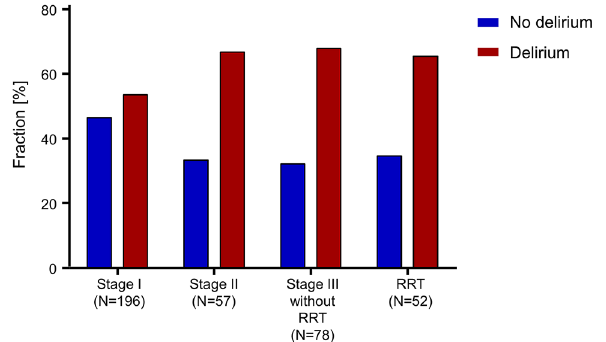
Figure 2. Delirium incidence and stage of acute kidney injury. Graph shows distribution of delirium positive patients per stage of acute kidney injury. Stage III was separated in patients with and without renal replacement therapy (RRT).